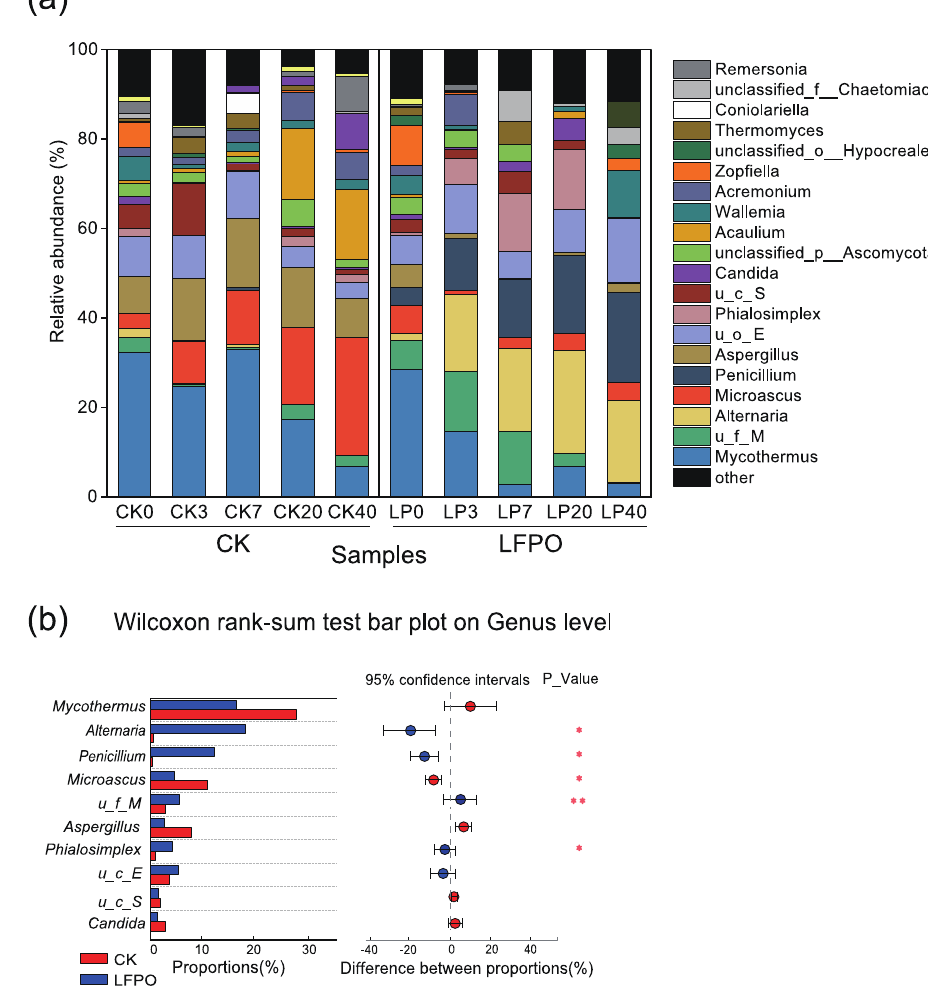
Figure 3. The fungal structures during composting. ( a ) The relative abundance of fungal taxa at the genus level; taxa with <1% reads were combined as “others”. ( b ) Wilcoxon rank-sum analysis of significant fungal genera between compost without and with inoculation; **, and * represent p < 0.01, and p < 0.05, respectively.